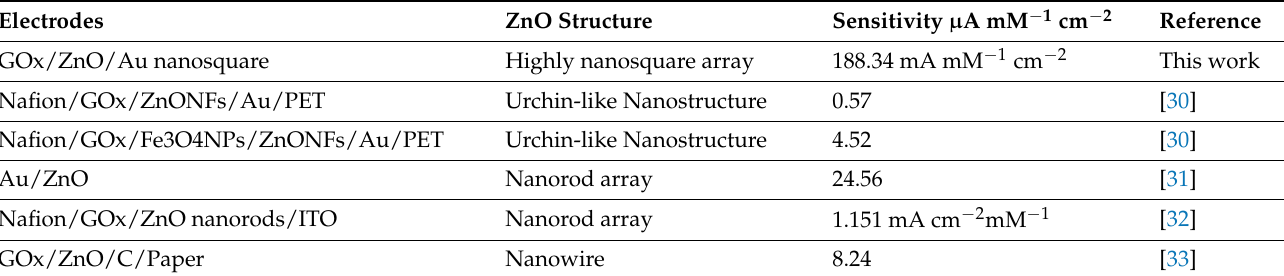
Table 1. Comparison of the glucose sensor performance based on ZnO.